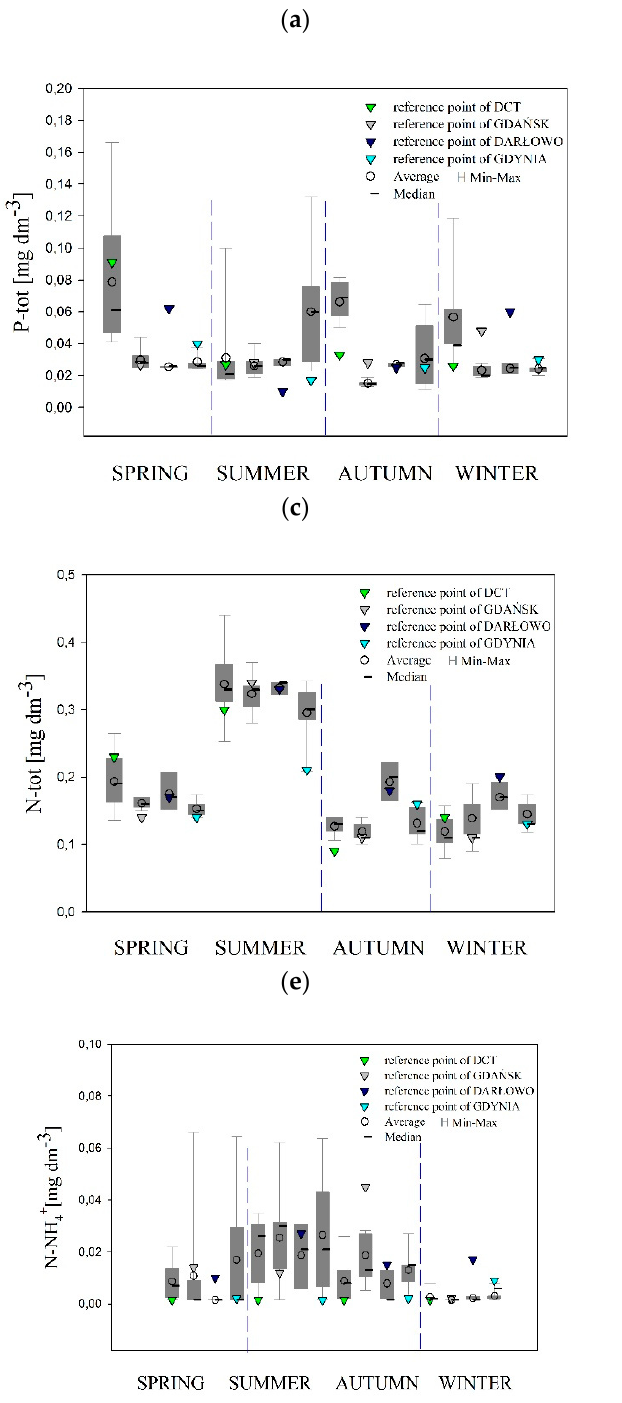
Figure 5. Concentrations of nutrients ( a ) P-tot, ( b ) P-PO 4 − 3 , ( c ) N-tot, ( d ) N-NO 3 − , and ( e ) N-NH 4+ in the collected samples of the four dumping sites. The results are divided into seasons, and for each season of the year the graphs, starting from the left, represent DCT, Gda ń sk, Dar ł owo, and Gdynia, respectively. Vertical bars depict the variation ranges, circles show average values, and dashes depict medians of concentration. The vertical boundaries of the rectangles show the range of 25–75% of concentration. The triangles represent the concentration value measured at reference points outside of the dumping sites.